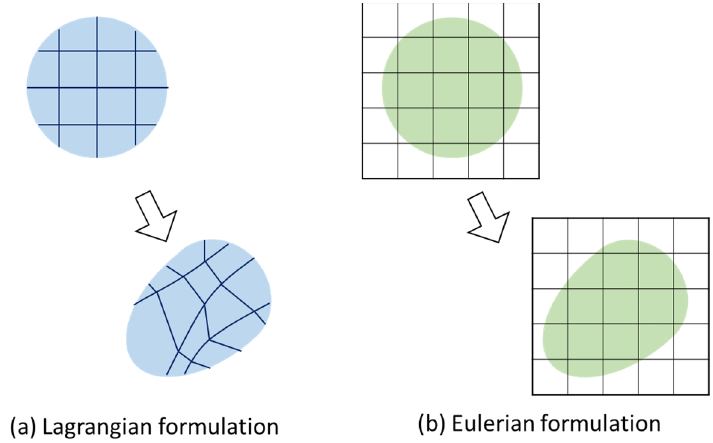
Figure 3. Deformation of a continuum in ( a ) Lagrangian and ( b ) Eulerian formulation.